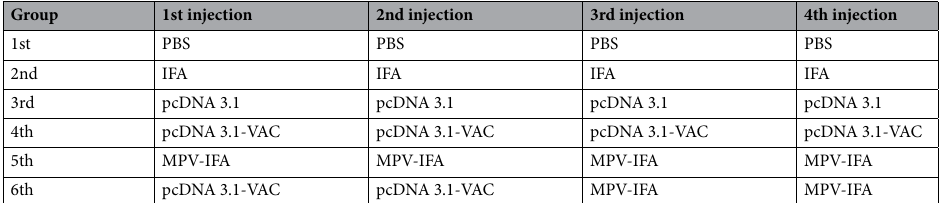
Table 1. Vaccination schedule at different immunization groups. IFA: Incomplete Freund’s adjuvant, PBS: Phosphate buffer solution, n: Number of mice per group, pcDNA 3.1/VAC: The multiepitope DNA vaccine, MPV: The multiepitope peptide